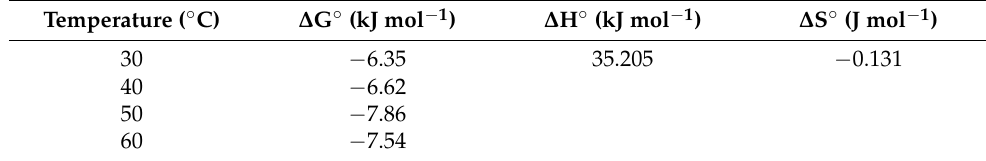
Table 6. Thermodynamic factors of the sorption of IV MB 2R onto S. latifolium